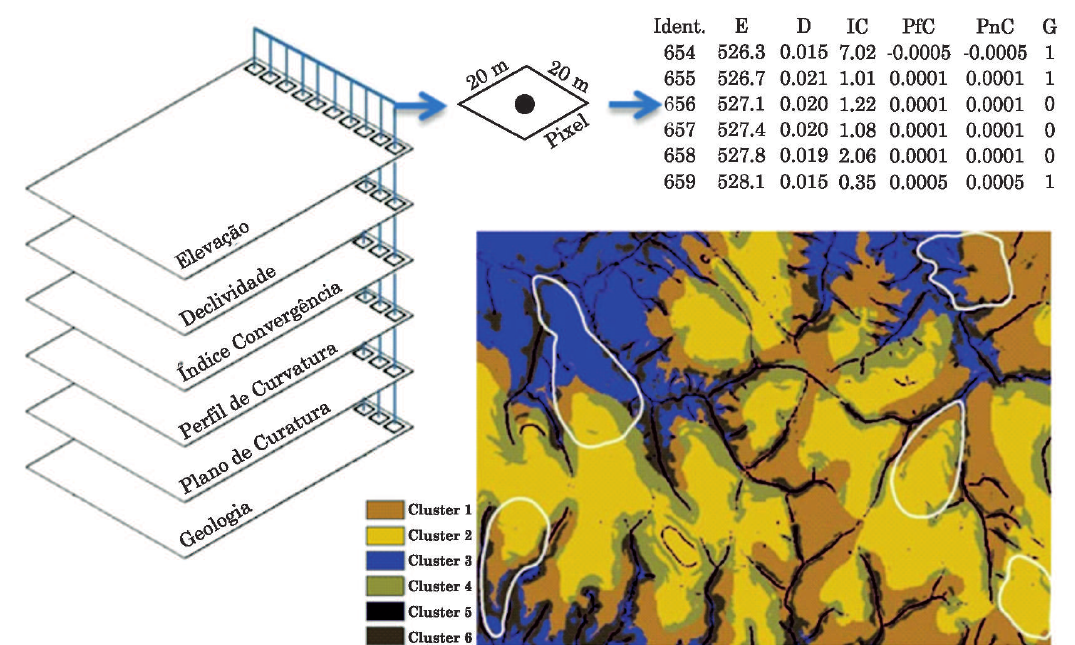
Figura 1. Dados para análise de agrupamento, distribuição dos clusters e localização das cinco áreas de